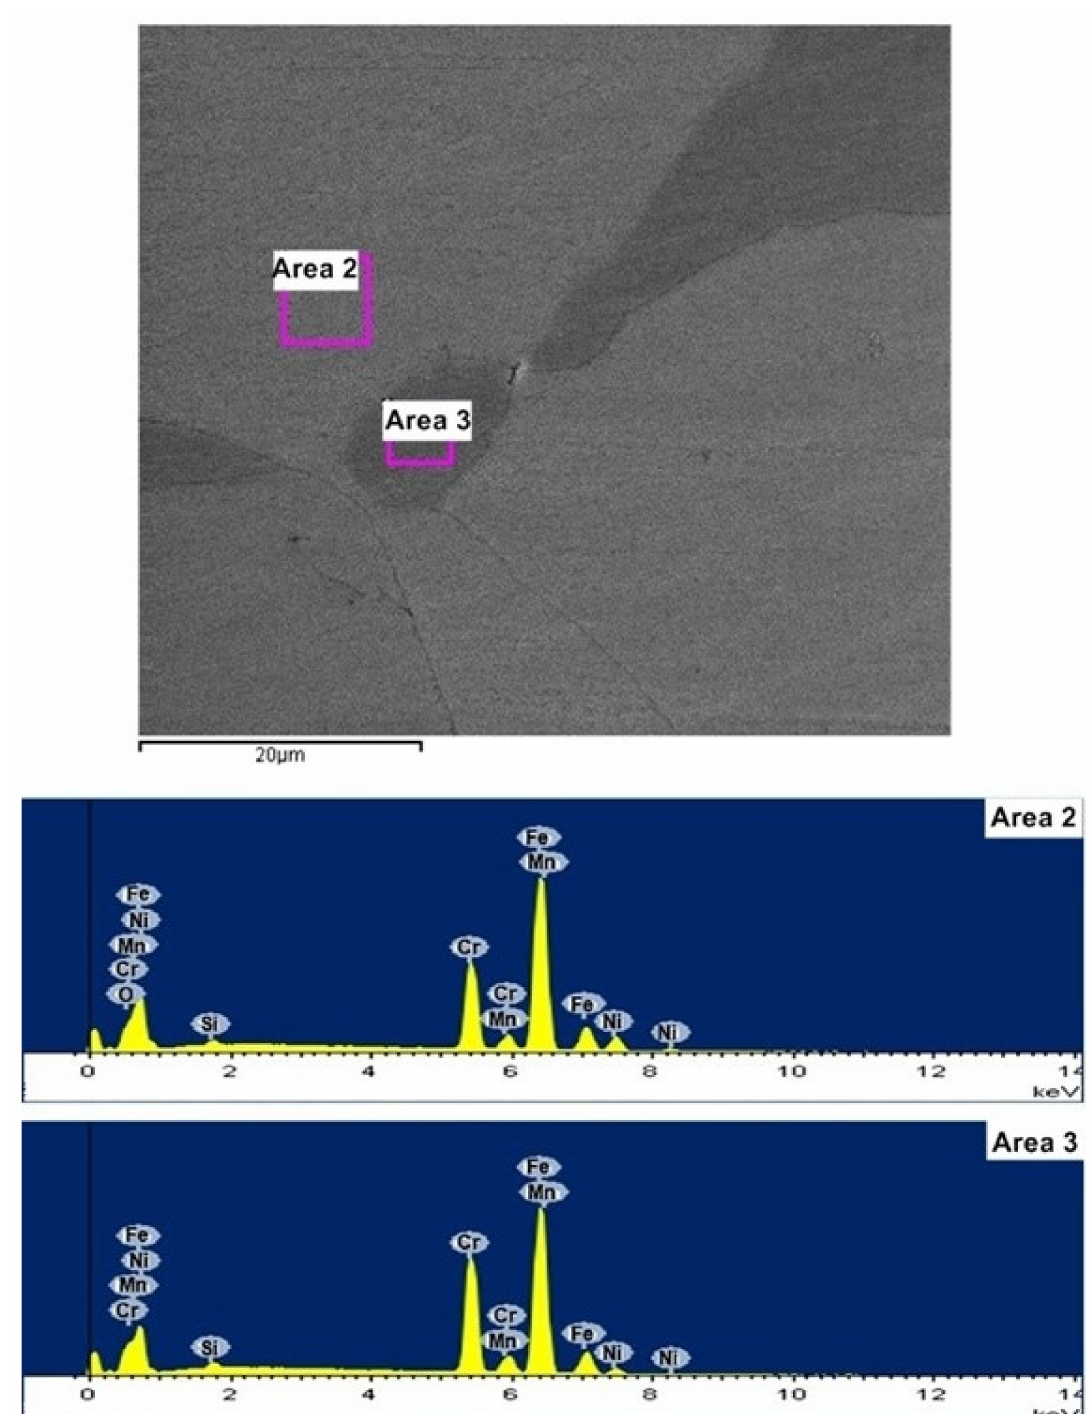
Figure 7. Composition of surface film of 304L stainless steel in nitric acid liquid